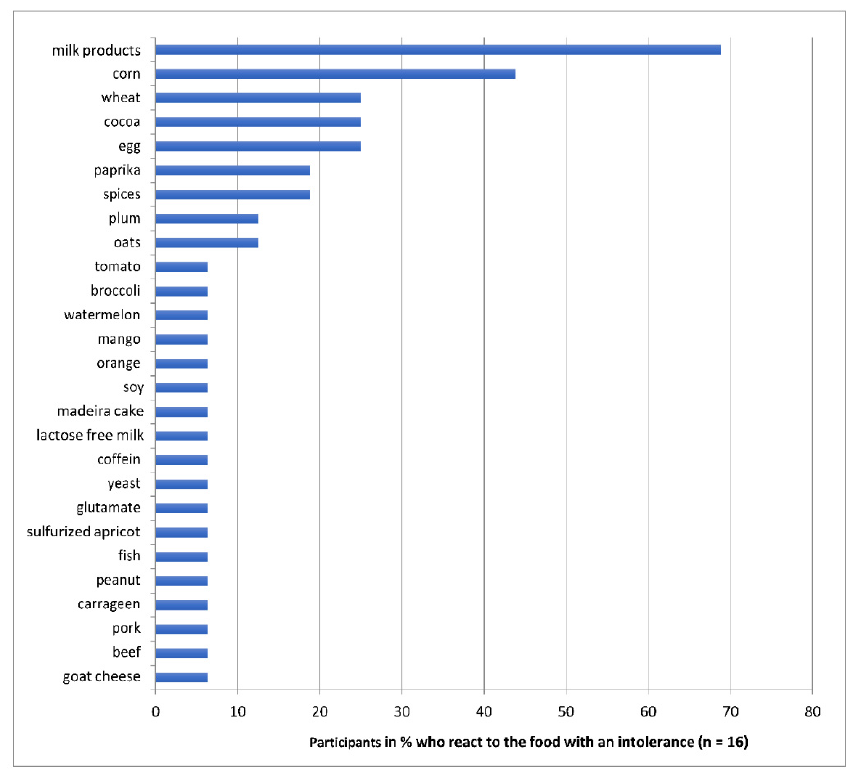
Figure 3. Identified food sensitivities during the study: Percentages of children ( n = 16) reacting to the respective food with an increase in ADHD symptoms.